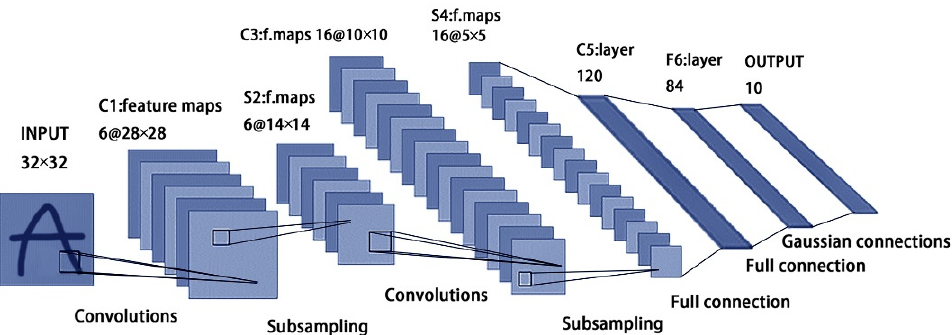
Figure 4. LeNet-5 network model structure.